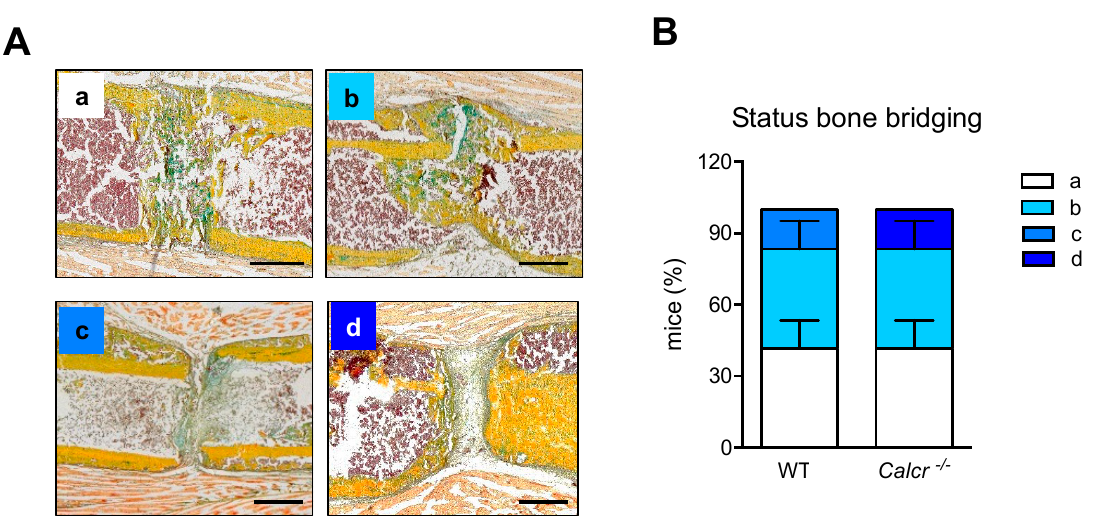
Figure 5. Interruption of CT/CTR-signaling does not significantly alter callus bridging. ( A ) Exemplary callus images (Movat Pentachrome staining) at day 21 following osteotomy, indicating the four different scores used for the following semiquantitative measurement of callus bridging. a = complete bridging (all four cortices bridged by callus; image derived from Calcr -/- ), b = partial bridging (two to three cortices bridged by callus; image derived from Calcr -/- ), c = incomplete bridging (callus present, but no bridging visible; image derived from WT), and d = nonunion (rounded cortices, minimal presence of callus; image derived from Calcr -/- ). Scale bars = 500 µm. ( B ) Semi-quantitative evaluation of callus bridging in WT and CTR-deficient mice at day 21 following osteotomy in the callus sections of WT and Calcr -/- mice the indicated time points by two blinded investigators. n = 4–6 mice per group. Box plots represent median with minimum and maximum whiskers.